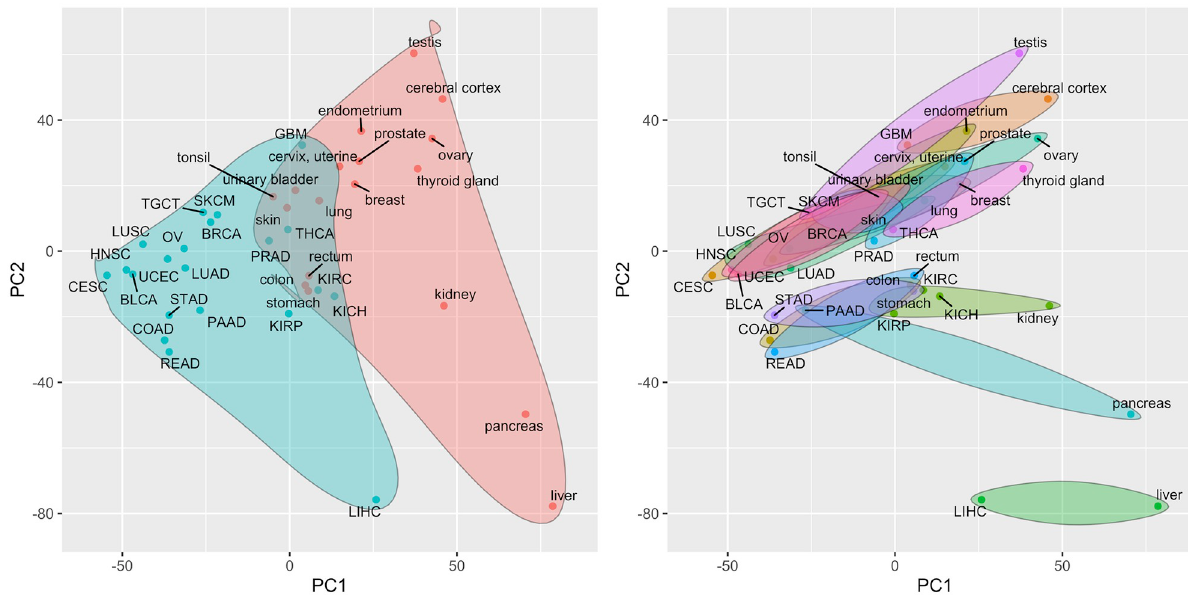
Fig 1. Projection of TCGA cancer types and associated HPA normal tissues onto the first two principal components of the mean expression values. Principal components are computed from a matrix of mean gene expression values, i.e., a matrix containing all c i , j and n i . j statistics. a) Cancers are represented by blue points and are enclosed in the blue shaded region; normal tissues are represented by red points and are enclosed in the red shaded region. b) Each normal tissue and the associated cancer type(s) are enclosed in a separate shaded region.